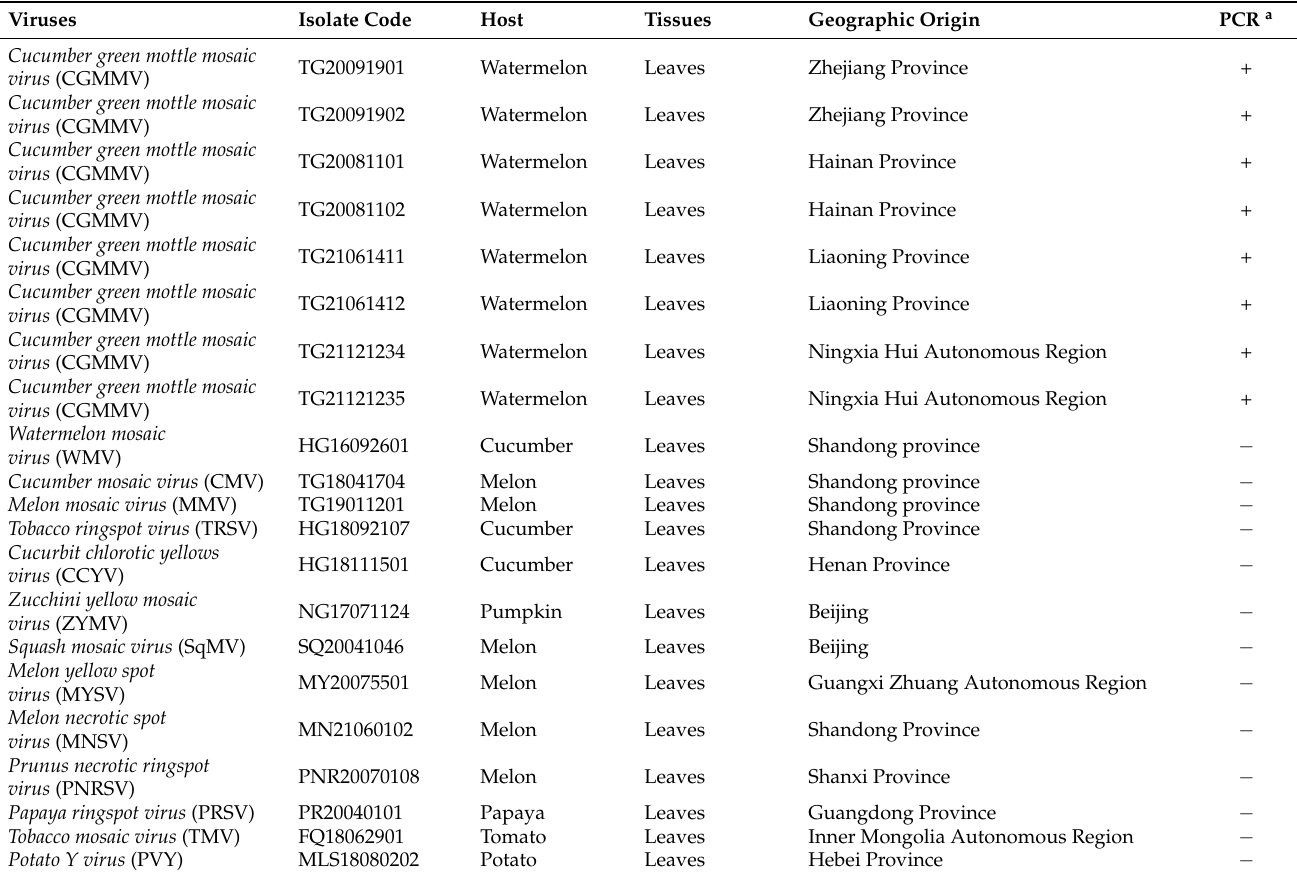
Table 1. Representative virus isolates used for primer specificity